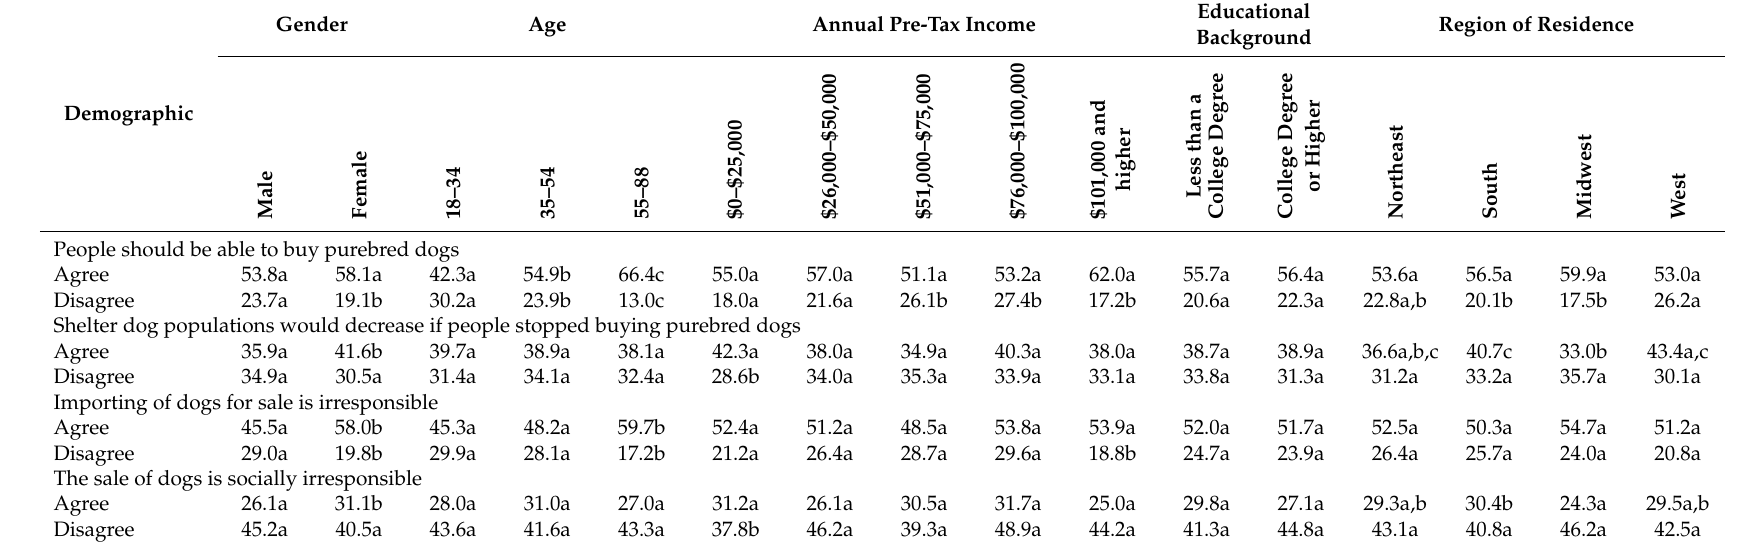
Table 4. Cross-tabulations of level of agreement regarding statements related to dog acquisition through sale and potential welfare aspects related to dog acquisition (% of respondents; n =